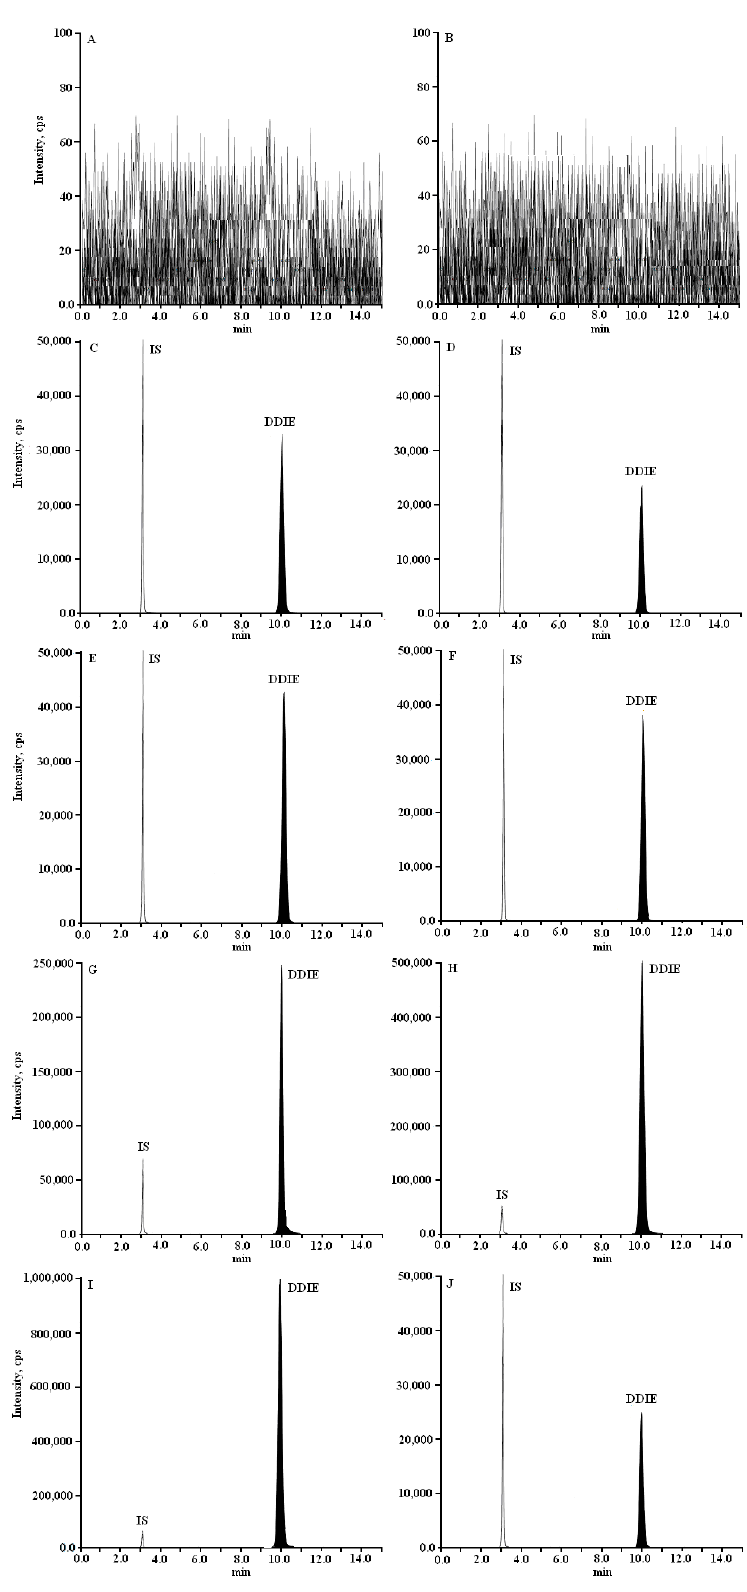
Figure 2. Representative MRM chromatograms of DDIE ( m / z 327.2/188.0) and daidzein (I.S.) ( m / z 255.0/199.2) in rat plasma and cerebral nuclei samples after intravenous administration of DDIE at a single dose of 40 mg/kg to rats: ( A ) blank plasma; ( B ) blank hippocampus; ( C ) blank hippocampus spiked with DDIE and I.S.; ( D ) hippocampus; ( E ) striatum; ( F ) hypothalamus; ( G ) cerebellum; ( H ) brainstem; ( I ) cortex; ( J ) plasma.